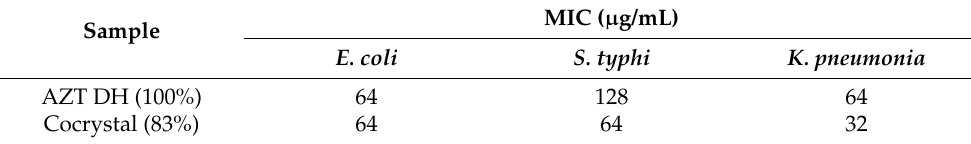
Table 3. MIC values of pure AZT DH and cocrystal against different bacterial